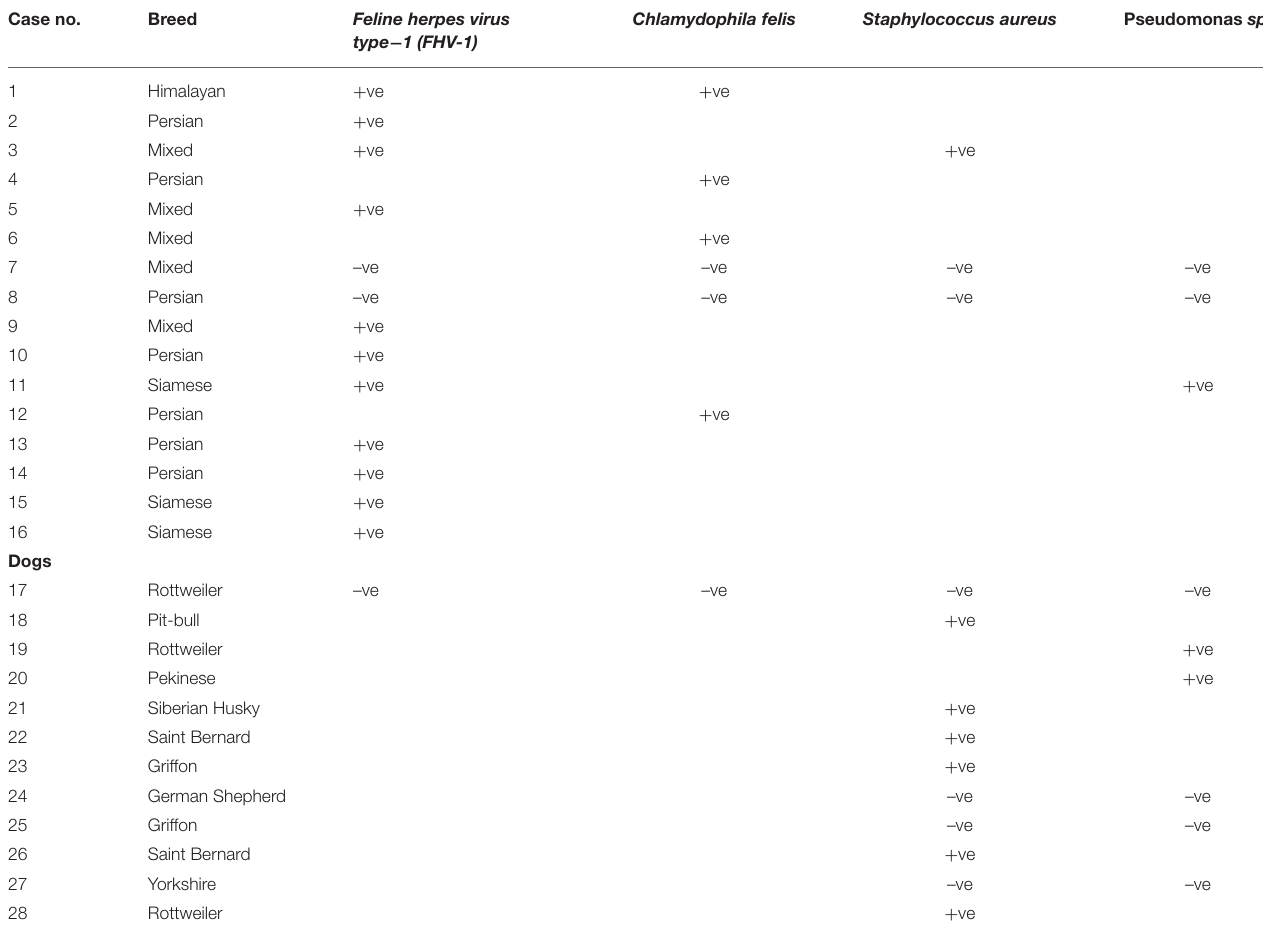
TABLE 5 | Microorganisms involved in corneal ulcers in dog and cat patients. Chlamydophila felis Staphylococcus aureus Pseudomonas Case no. Breed Feline herpes virus type − 1 (FHV-1)